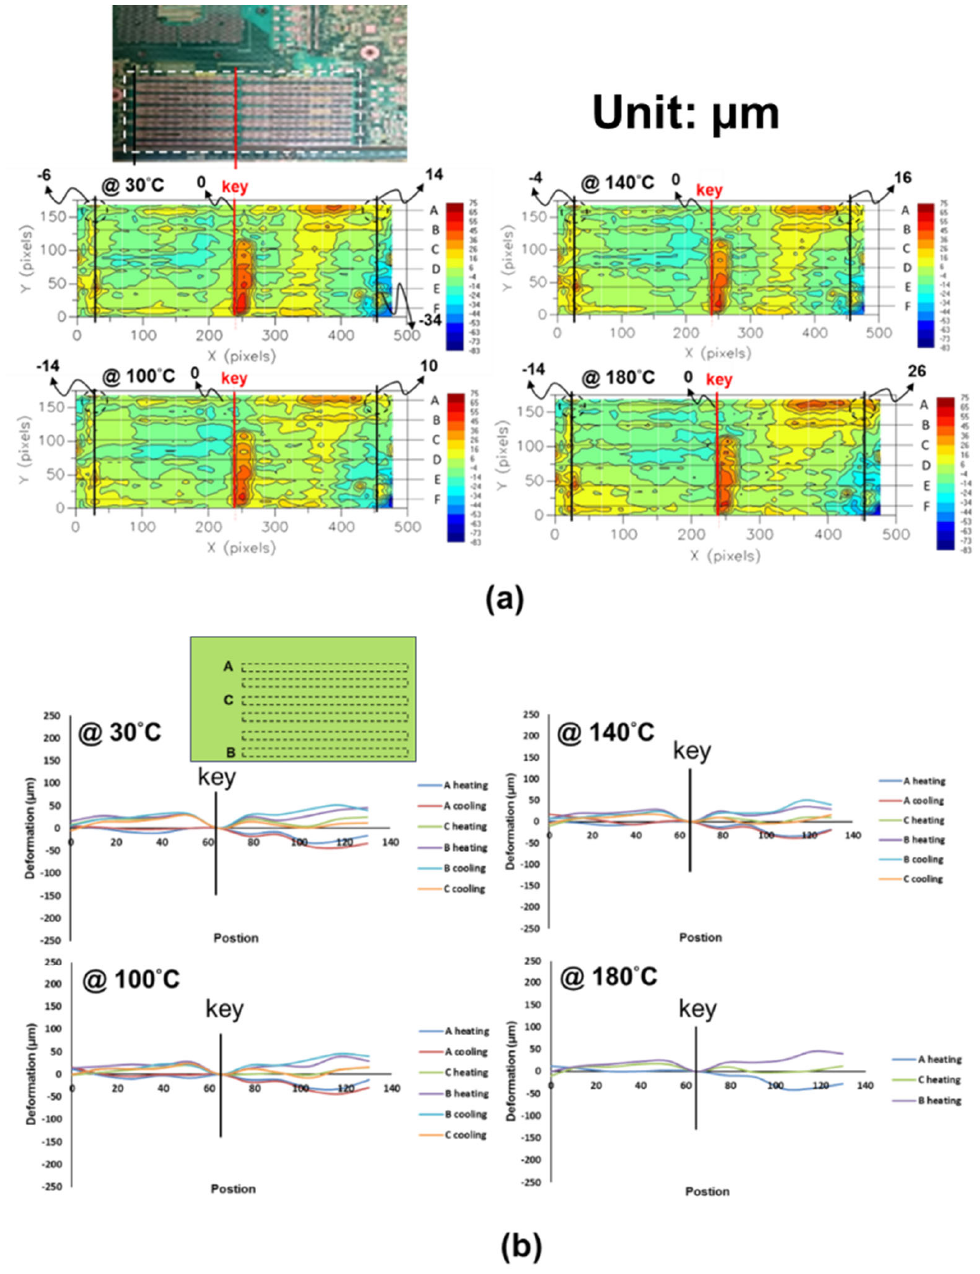
Figure 15. ( a ) Out-of-plane deformation contours (in dotted line box) for the bare PCB at various temperatures, obtained from moiré measurements, and ( b ) out-of-plane deformations of the bare PCB along three lines (A, B, and C) in which the sockets will be located.